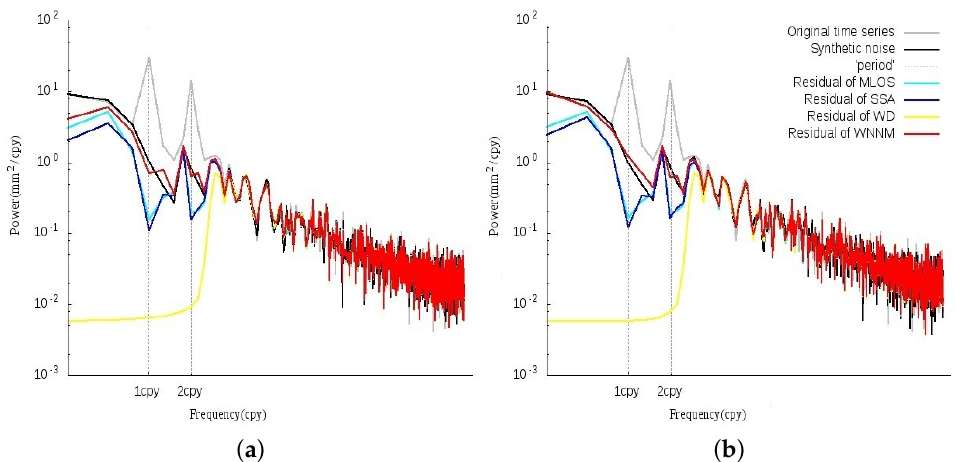
Figure 4. The PSD of original signal and residual time series estimated by different strategies, where σ f = 10mm/yr − k 4 . The horizontal axis is frequency and the unit is cycle per year (cpy), and the vertical axis is power. The gray solid line represent the original time series, the black solid line is the synthetic noise and cyan, blue, yellow and red represents residuals estimated by applying MOLS, SSA, WD and WNNM, respectively. ( a ) Without trend and ( b ) with a linear